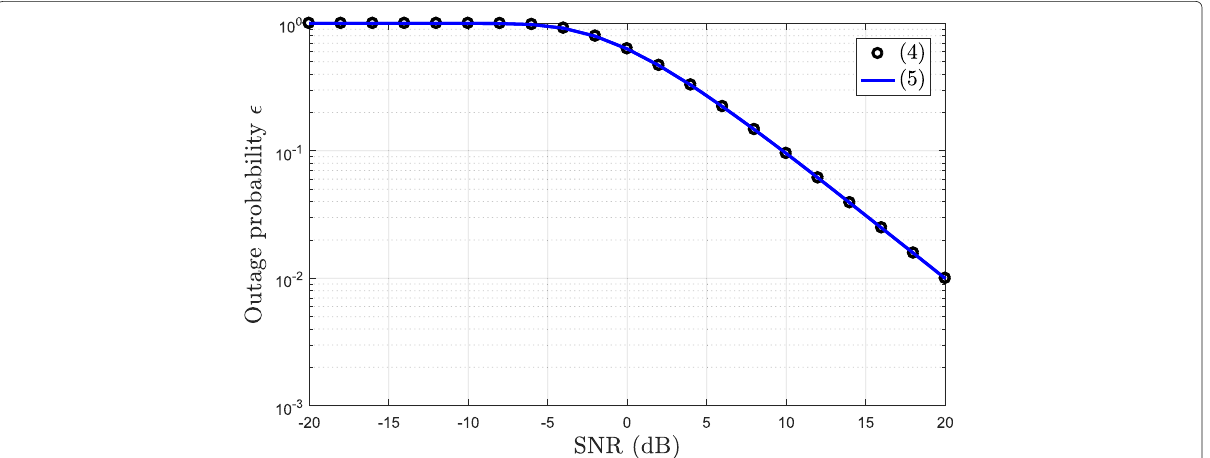
Fig. 3 Comparing the accuracy of approximated outage probability in (4) and (5). This figure compares the accuracy of outage probability with numerical integral of Q-function in (4) to the approximated outage probability in